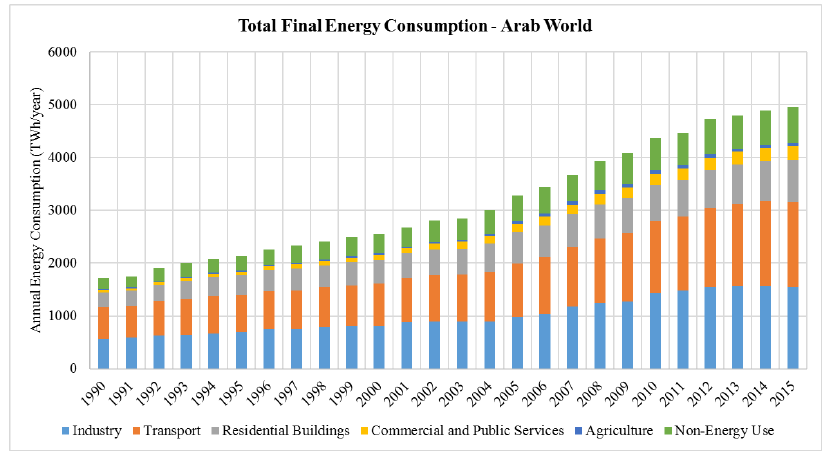
Figure 3. Annual total final energy consumption in the Arab region between 1990 and 2015.